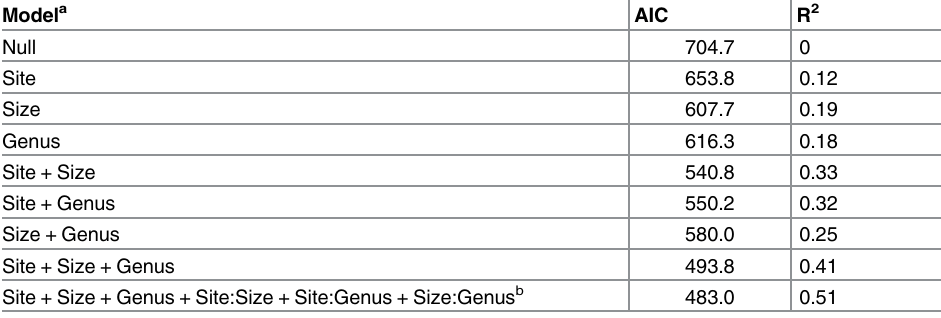
a All the models and the corresponding variables were signi fi cant at p = 0.05 con fi dence level. Interaction between variables is denoted by a colon. b